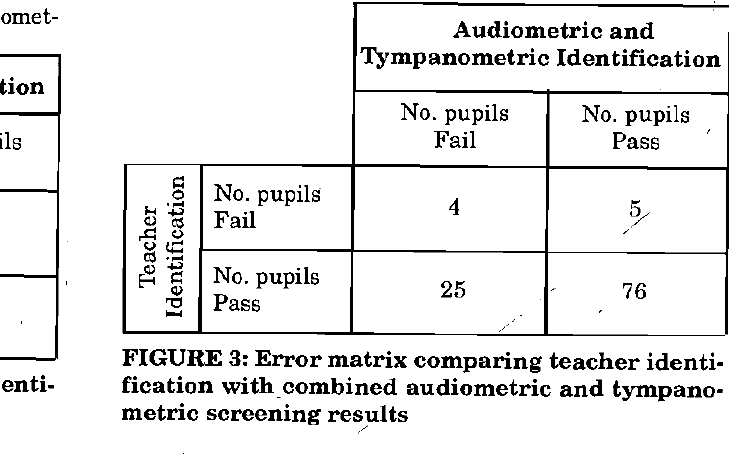
FIGURE 3: Error matrix comparing teacher identi- fication with combined audiometric and